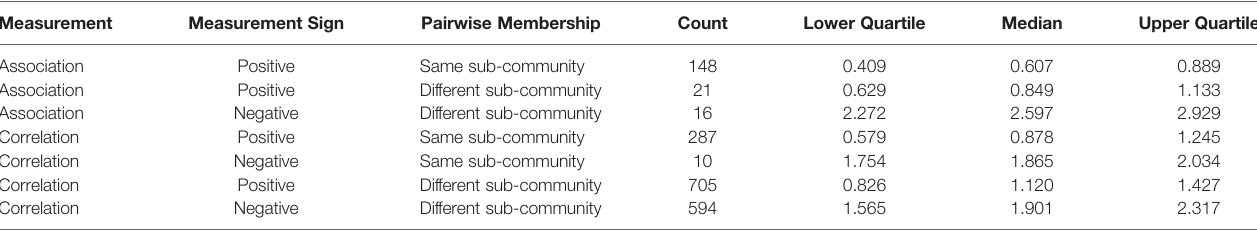
Correlation is further broken down into relationships that are between taxa within the same sub-community and those that are in different sub-communities. Values are accurate to three signi fi cant fi gures. Since correlations are symmetric we only consider values from the upper triangular portion of ^ S . TABLE 6 | Breakdown summary of mean niche distance by measurement (correlation or graph association), measurement sign (positive or negative relationship), and pairwise sub-community membership.